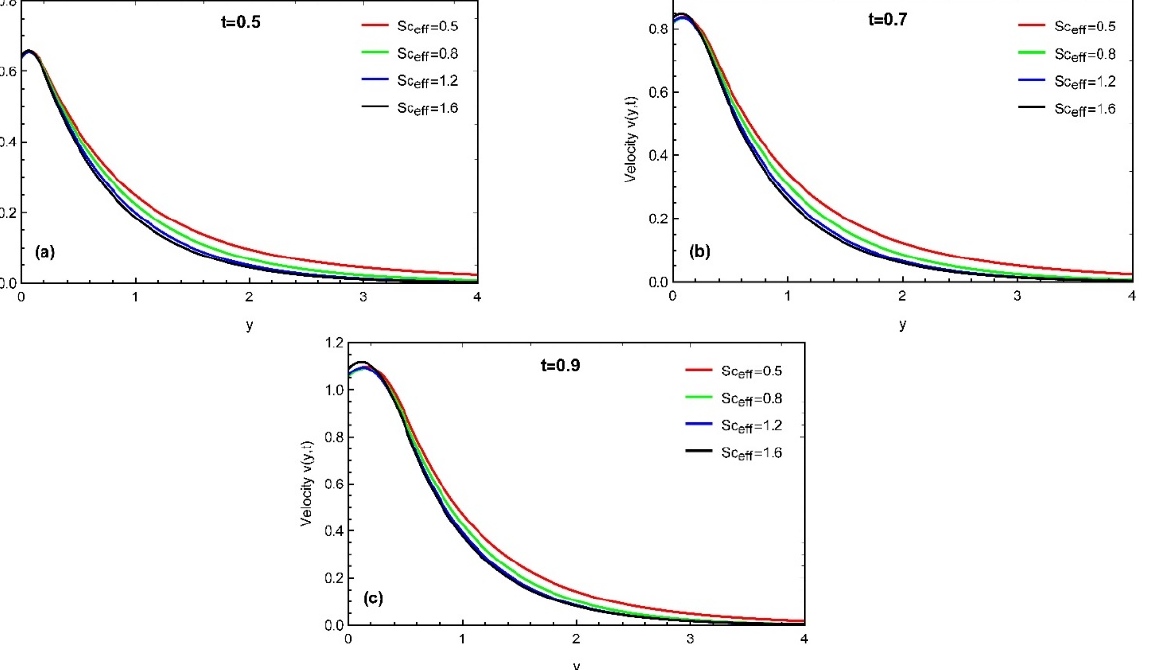
Figure 10. Variation in momentum field due to Schmidt number with α = β = γ = 0.7, Pr ef f = 1.4, Sc ef f = 1.1, M = 1.75, Gr = 0.75, Gm = 0.5, Re = 1.3, θ 1 = θ 2 = π at ( a ) t = 0.5 ( b ) t = 0.7 ( c ) t =